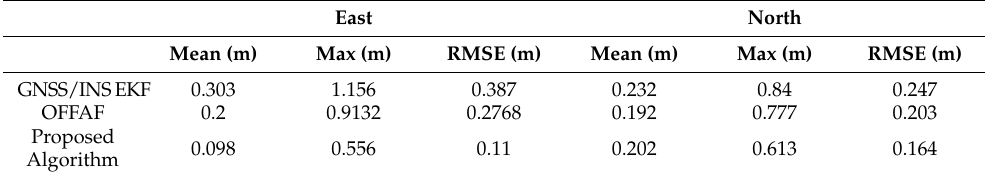
Table 3. The GNSS/INS integrated positioning performance of the EKF and the proposed algorithm.